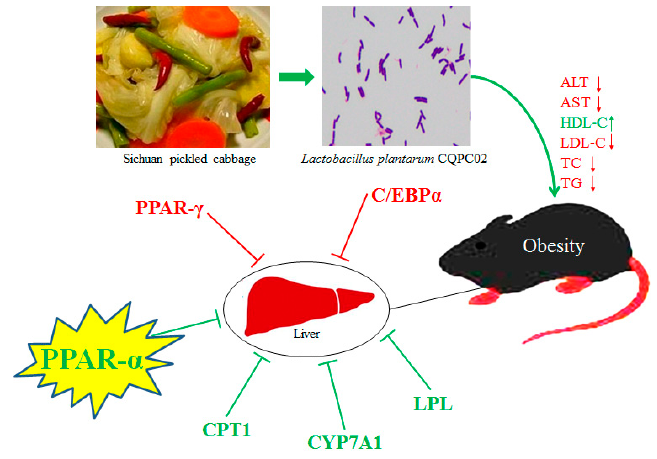
Figure 6. Action mechanism of Lactobacillus plantarum CQPC02.